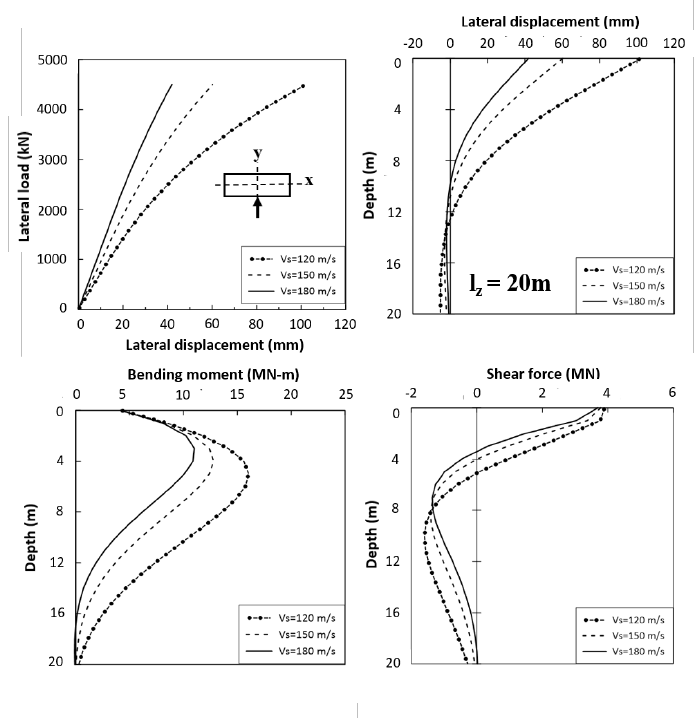
Fig. 6. Performance of 20m barrette in clays with load applied in transverse